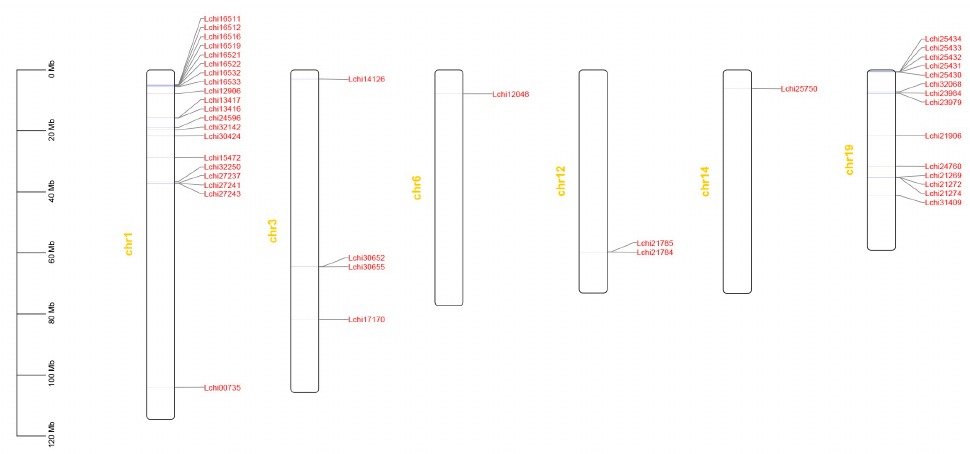
Figure 3. Distribution of the Terpen synthase genes on L. chinense chromosomes. The scale indicates a megabase (Mb).